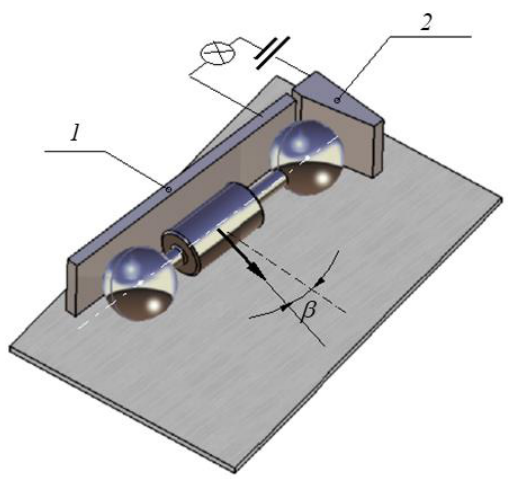
Figure 7. The launching position of the rotor: 1, 2 plates of the contact sensor.